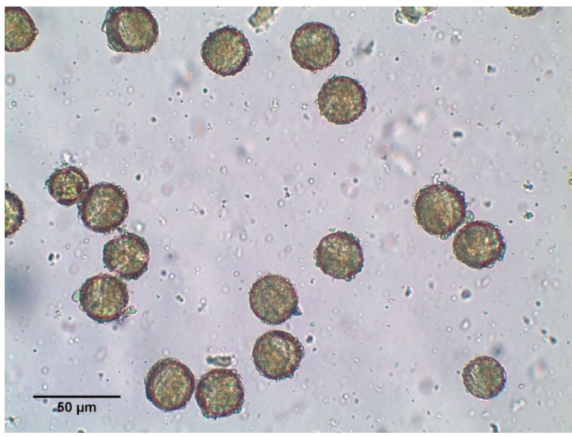
Figure 5. Microphotography of BB used in our